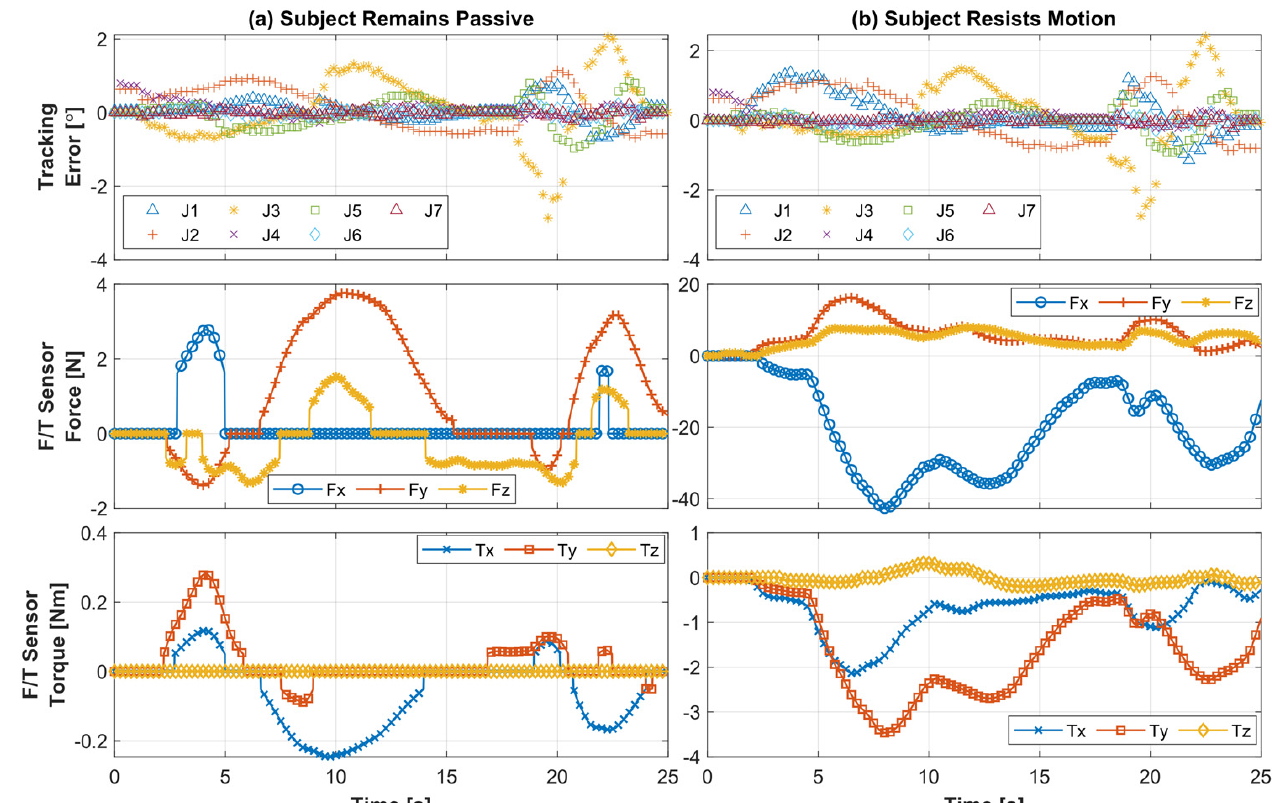
Figure 13. Force–torque interaction and associated tracking error for all seven joints’ passive exercise for Subject D, while the subject ( a ) remains passive during the motion and ( b ) resists the motion.